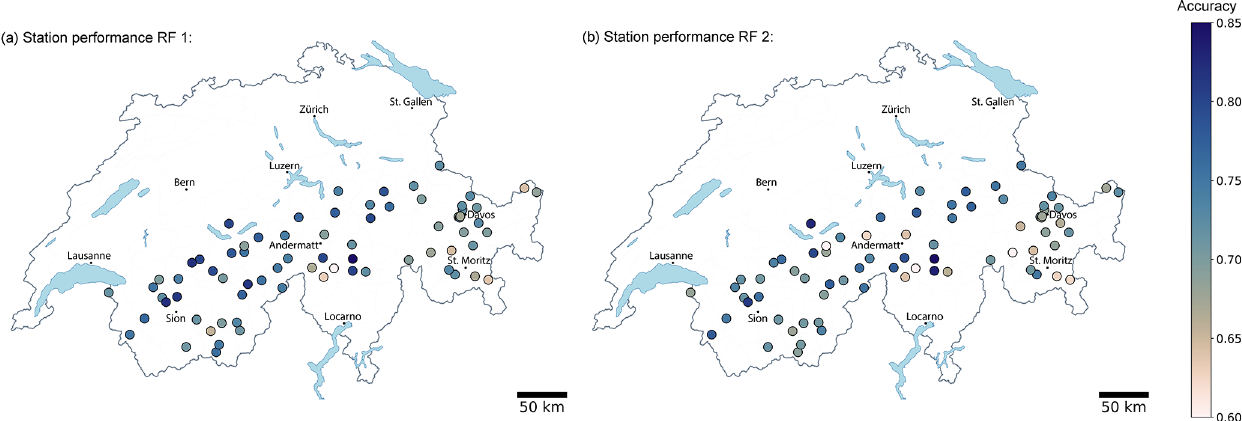
Figure 8. Maps showing the average accuracy of (a) RF 1 and (b) RF 2 model predictions for the 73 IMIS stations for which predictions were available on at least 50% of the test set ( D forecast ) days.